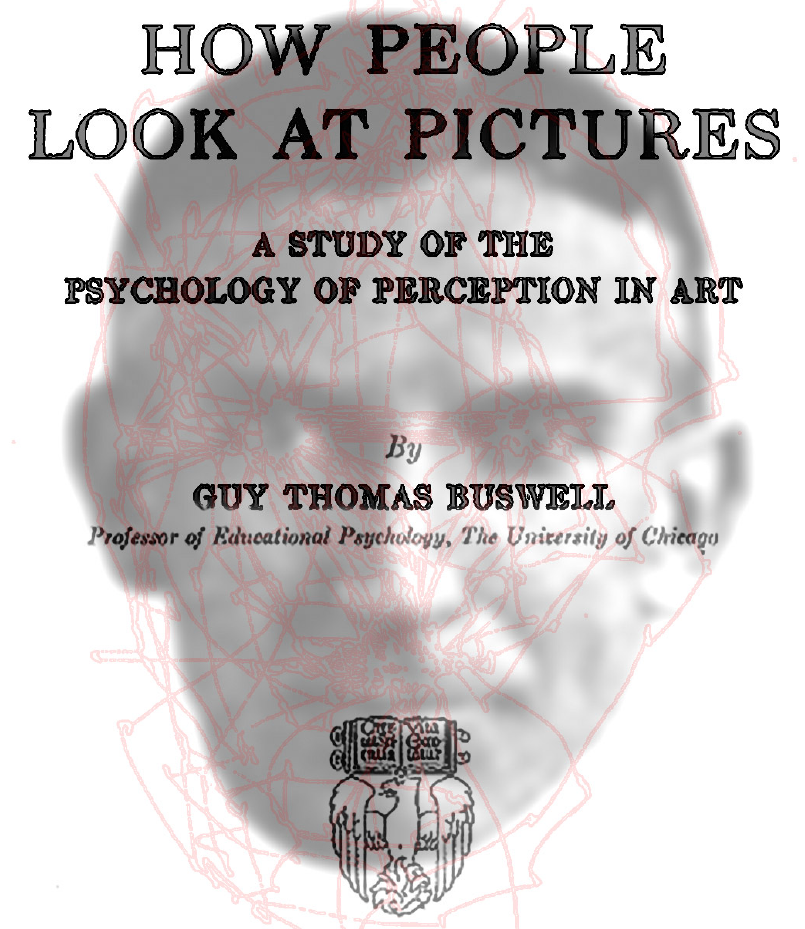
Figure 1. Buswell’s book . (Portrait adapted from an illustration in Taylor, 1937, and a conventional photographic copy can be found in Wade & Tatler, 2005; eye movement trace adapted from Yarbus,